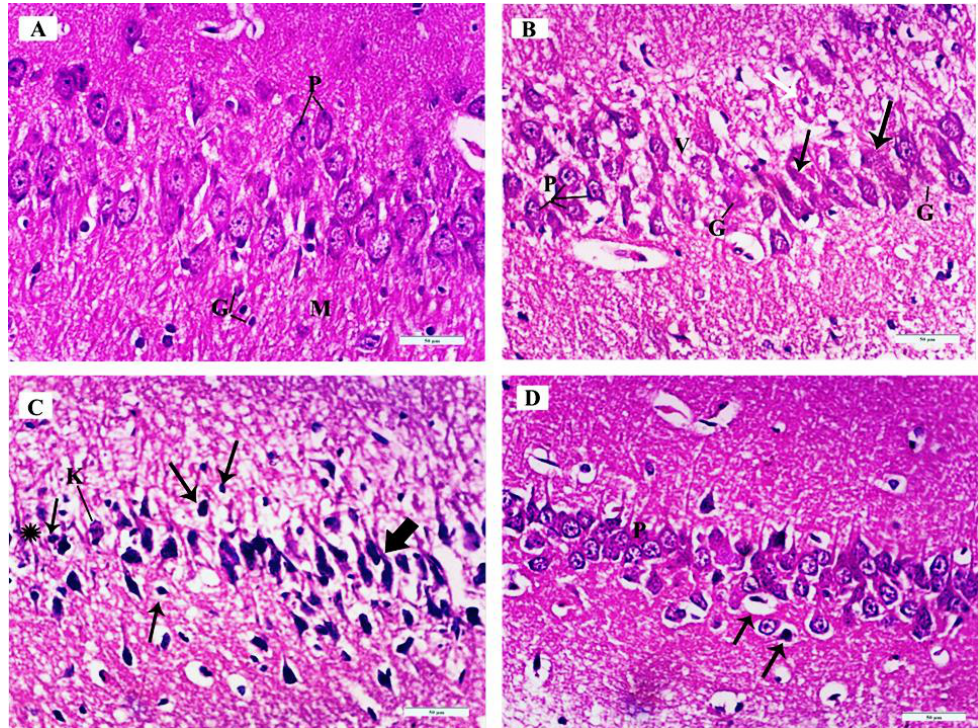
Figure 6. Photomicrographs of Hematoxylin and Eosin (H&E) -stained sections of the mouse hippocampus in the CA3 region of the different study groups; ( A ) control group and ceftriaxone group; pyramidal cell-layer neurons (P) are uniform in size and evenly arranged. Each neuron has a rounded central vesicular nucleus with prominent nucleolus. The cytoplasm contains prominent basophilic cytoplasmic Nissl's granules and is surrounded by thin neuropil. The molecular layer (M) contains many glial cells (G) among the neuronal processes. ( B ) ARS group; pleopathologic changes of most of pyramidal neurons' nuclei as well as vacuolated cytoplasm (V). Some pyramidal cells have vesicular nuclei with clogged marginated chromatin and prominent nucleoli (P); others show pyknosis (white arrow). Few neurons show homogenous nuclei and eosinophilic cytoplasm (arrows) and others have ghost changes (G). ( C ) ARS group; most of the neurons are shrunken, with hyperchromatic nuclei (thick arrows) and vacuolated cytoplasm; others have pyknotic nuclei (thin arrows) or karyolysis (K). Areas devoid of pyramidal neurons (asterisk) are observed. ( D ) ARS + ceftriaxone group; pyramidal neurons are heavily crowded with thin neuropil in between. They have basophilic cytoplasm, well-formed Nissl's granules, and vesicular nuclei (P). Few cells have pyknotic nuclei with vacuolated cytoplasm (arrows). (Hx. & E. × 400).